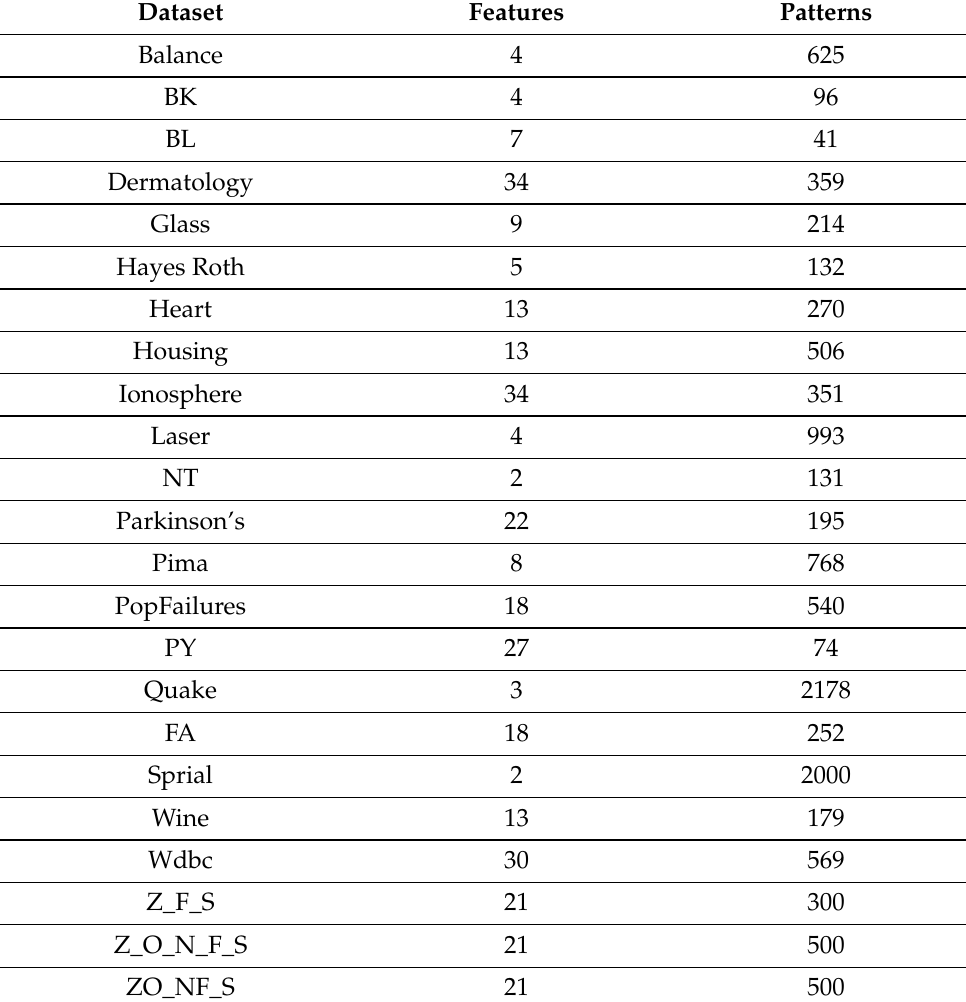
Table 3. Features and patterns for every experimental